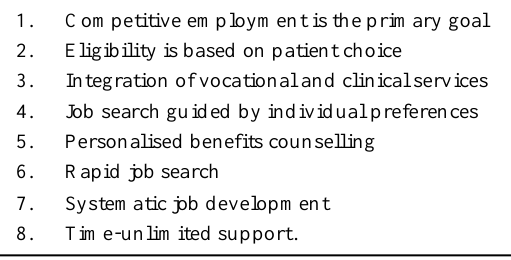
Figure 1. The principles of IPS Supported Employment.